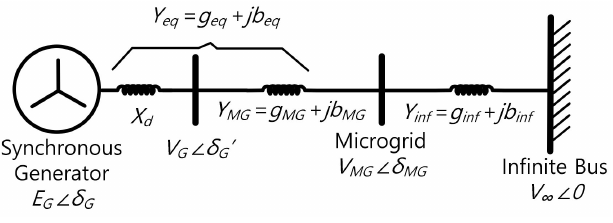
Figure 3. Single-machine microgrid